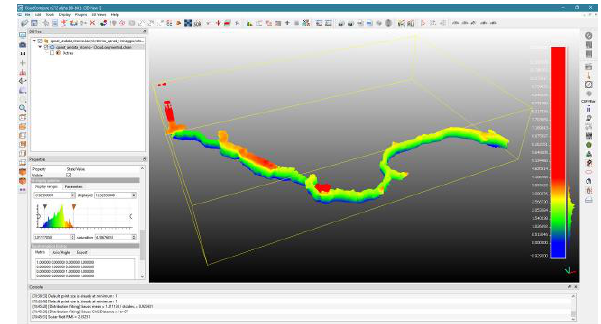
Figure 11 . Scalar Fields gradient output and histogram